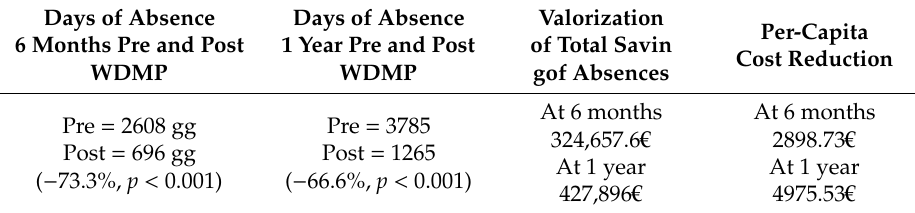
Table 2. Economic evaluation of illness related days of absence before and after WDMP.